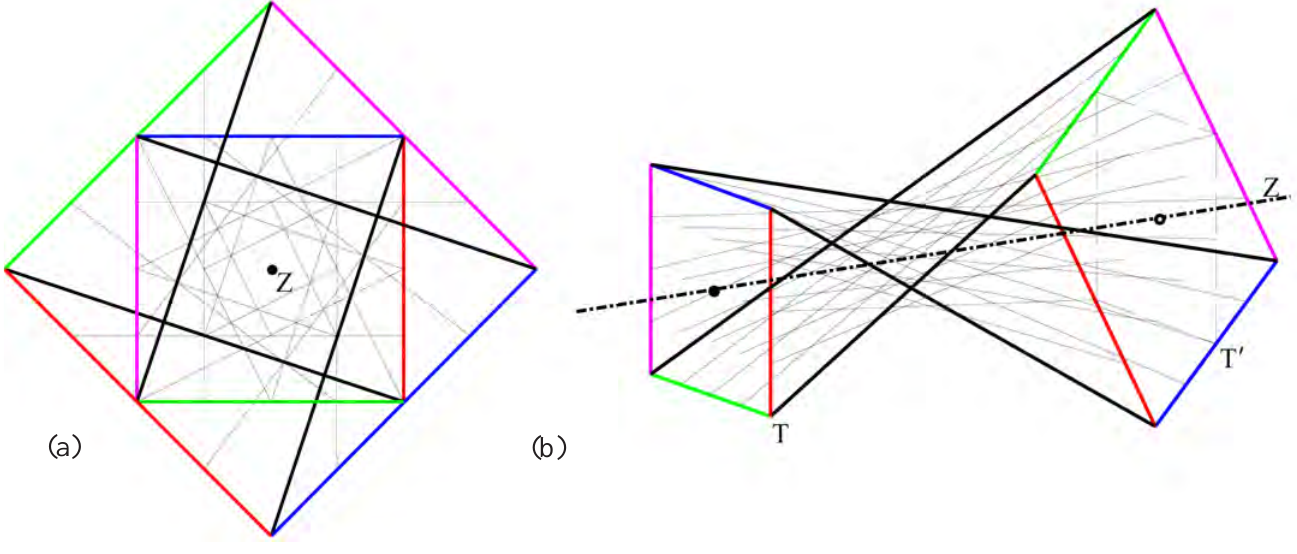
Figure 9 A pencil with divergency 2/ LIM +−= D at T. There are no principal meridional planes or foci. (b) azimuth °− 64 34 °− 64 , elevation 14 °− 64